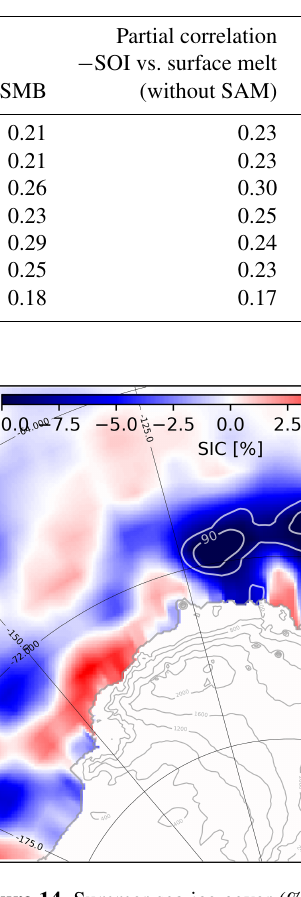
Table 5. Partial correlation of − SOI vs. SMB or melt rates, removing the influence of SAM (columns 2 and 4). Corresponding full correlations are indicated in columns 3 and 5 (same as Tables 3 and 4).